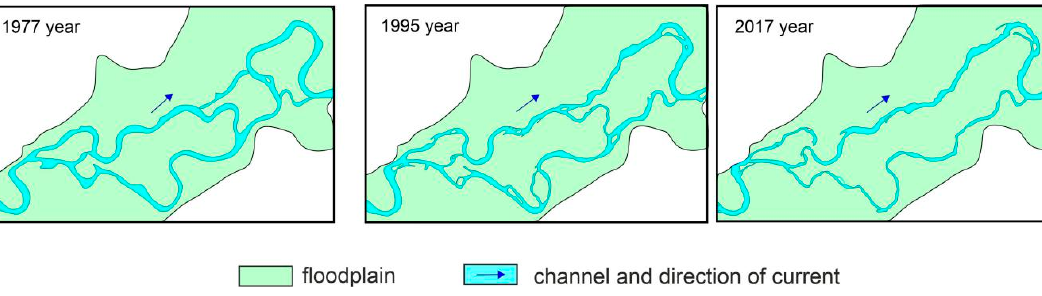
Figure 10. The most dynamic stretches of the Irkut channel (Maksimovshchina—the mouth).